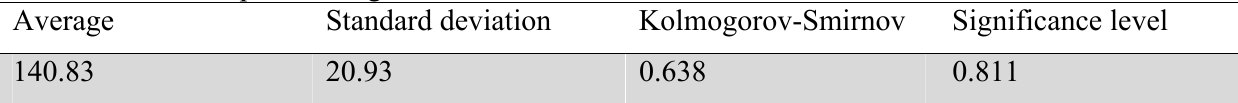
Results of one sample Kolmogorov-Smirnov